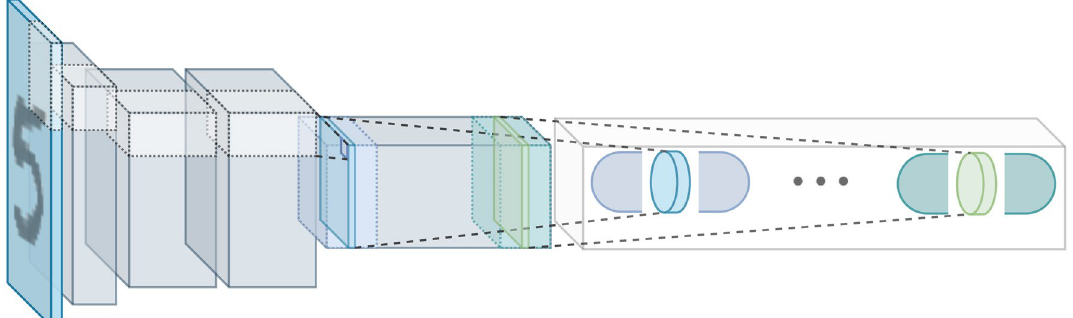
Figure 3. The first part of the network can be modelled as single-function H Conv that maps the input image l onto a higher-dimensional space. Then, the primary capsule layer S n , d is obtained with a depthwise separable convolution that greatly reduces the number of parameters needed for the capsules and F of the H Conv function, it is possible to obtain the primary capsule layer S l n , d where n l and d l are the number of primary capsules and their individual dimension of the l -th layer, respectively. The depthwise separable convolution is an efficient operation that greatly simplifies and reduces the number of parameters required for the capsule creation process. We leave it to discriminative learning to make good use of its filters to smartly extract all capsule properties.